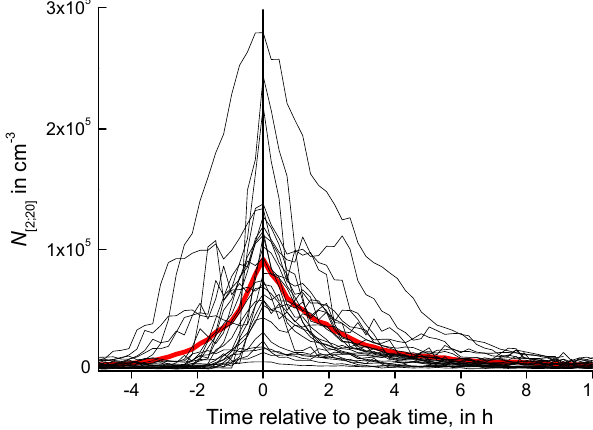
Figure C1. Time series of N [ 2 ; 20 ] for the 27 manually selected NPF events listed in Table C1. The red curve indicates the arithmetic average of the time series, which are shifted so that they coincide in maximum number concentration.